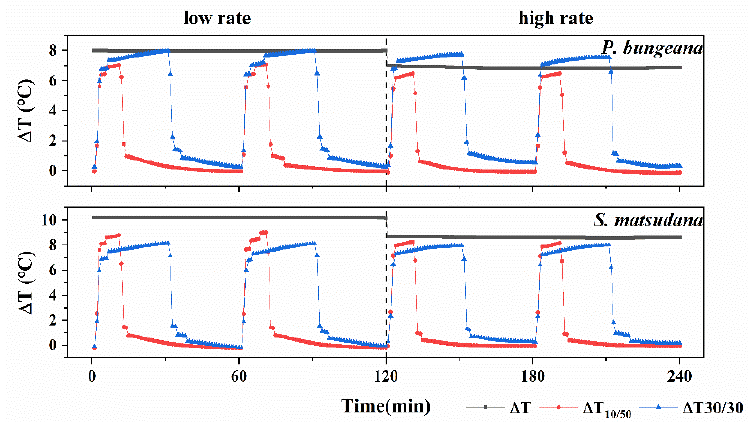
Figure 3. Temperature difference changes within hours of low (left side of dotted line) and high (right side of dotted line) sap flow rates under continuous heating ( ∆ T, black), 10 min heating and 50 min cooling ( ∆ T 10/50 , red), and 30 min heating and 30 min cooling ( ∆ T 30/30 , blue).